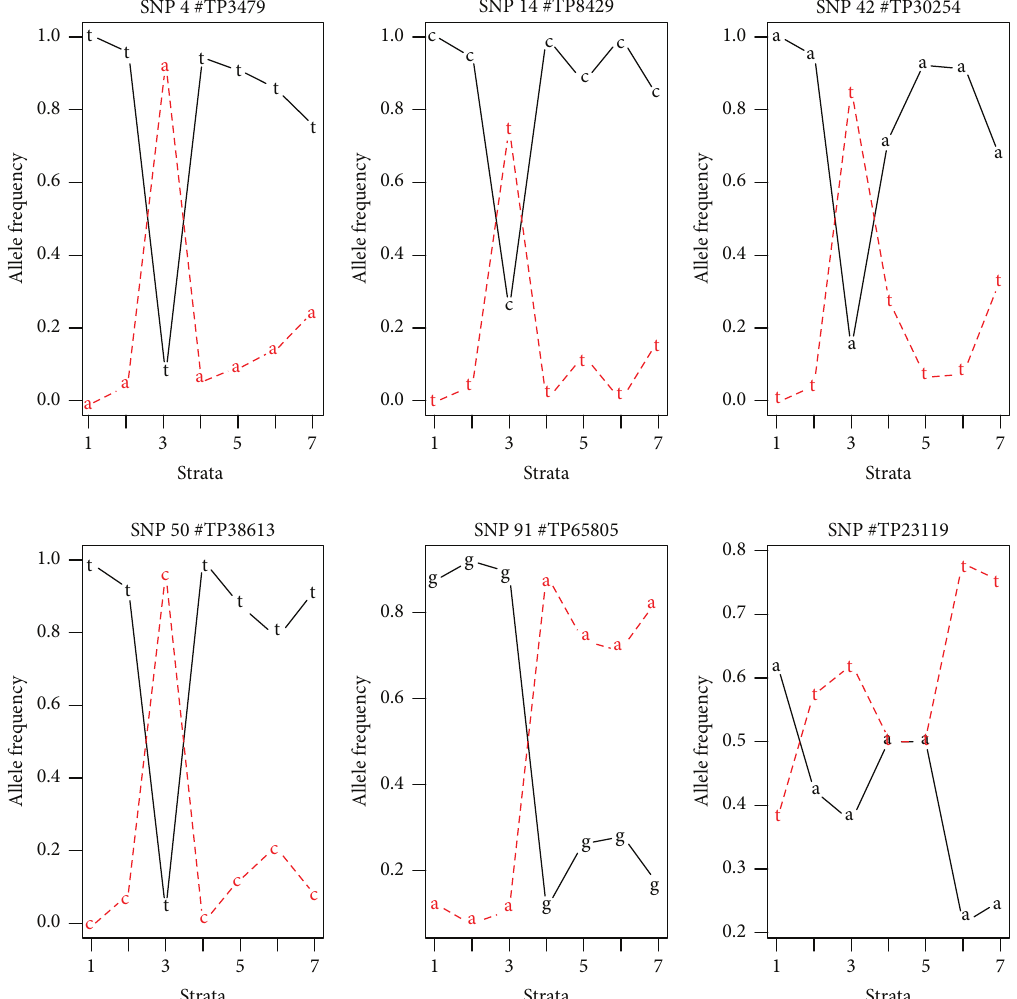
Figure 4: Spatial distributions of single nucleotide polymorphism (SNP) loci/genotypes in N. dombeyi in Chile for each strata. The graphs show frequencies of loci/genotypes differentiating among strata (SNP #3479, SNP #8429, SNP #30254, SNP #38613, and SNP #65805) and no differentiating among strata (SNP